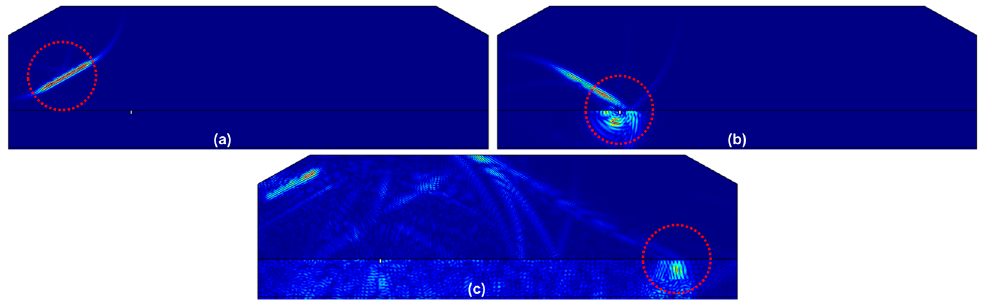
Figure 3. Simulation results of Rayleigh wave propagation: ( a ) 5 μ s, ( b ) 10 μ s, and ( c ) 15 μ s.